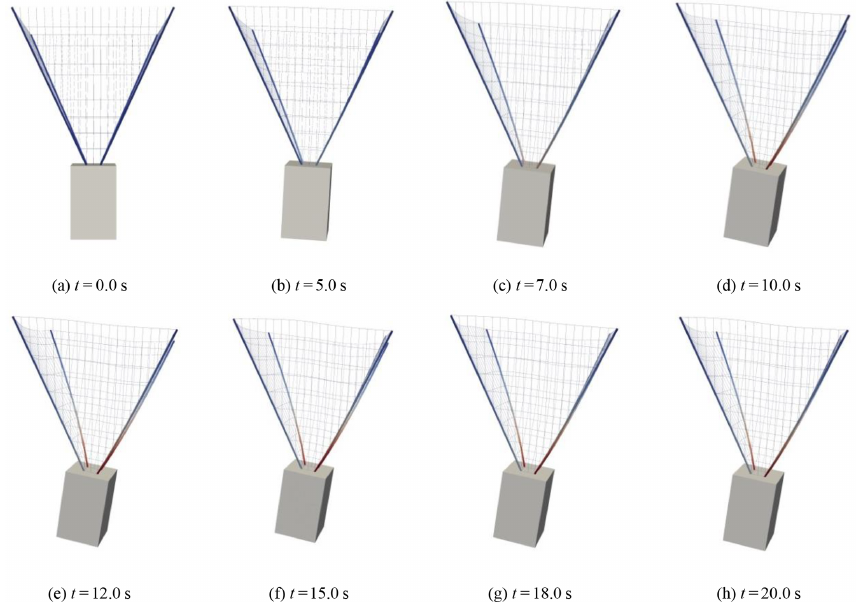
Figure 20. Procedure of attitude maneuvering.